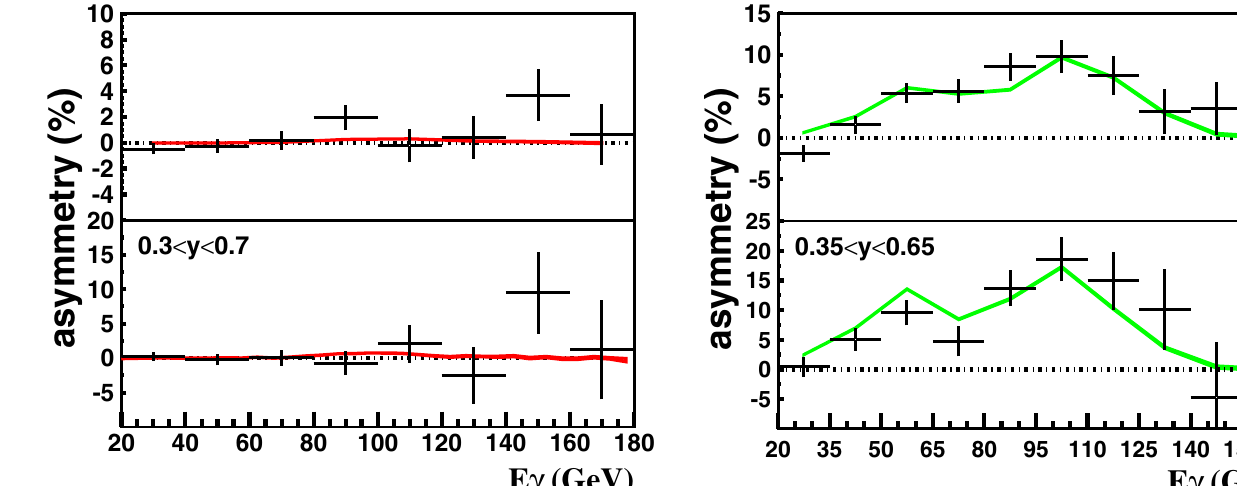
FIG. 16. (Color) Asymmetry to determine the (cid:2) the CB photon polarization with the Ge analyzer. Measurements without (top) and with (bottom) the quasisymmetrical pair se- lection at roll angles 0 (cid:9) (cid:5) are compared to those at roll angles (cid:5)= 2 (cid:9) 3 (cid:5)= 2 .